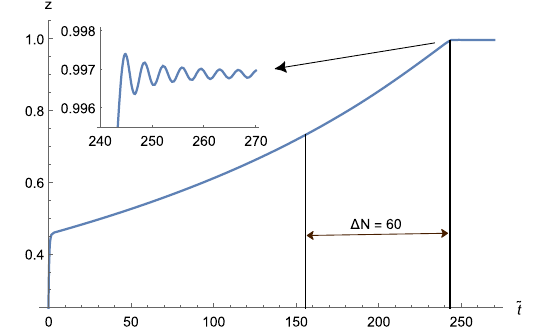
Fig. 3 The inflationary solution z ( ˜ t ) to the equations of motion (30) and (31)withtheinitialconditions z ( 0 ) = 1 / 4, ˙ z ( 0 ) = 1 / 2.Thevertical lines represent the last 60 e-folds of inflation